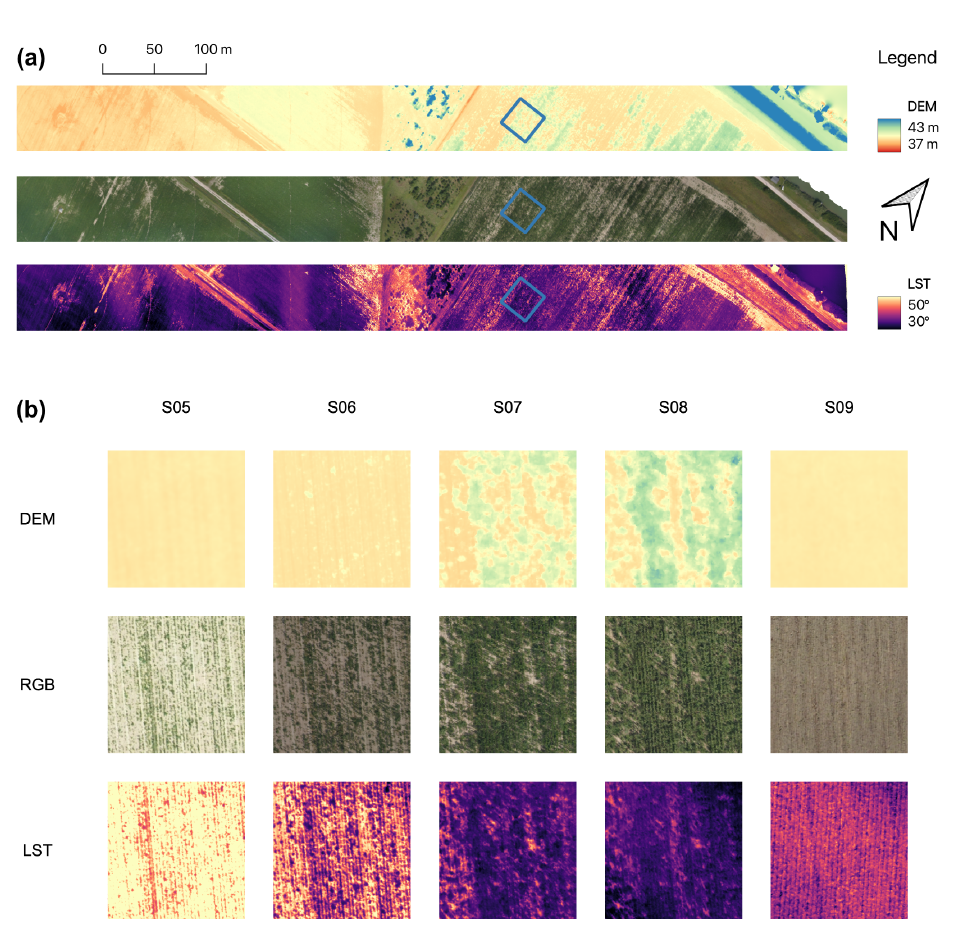
Figure 6. Final processing results of the UAV surveys: from top to bottom the DEMs, the RGB mosaics and the LST mosaics. ( a ) The entire 5 ha survey area in the S07 survey; ( b ) A sample area (highlighted in ( a ) in blue) in all the production surveys